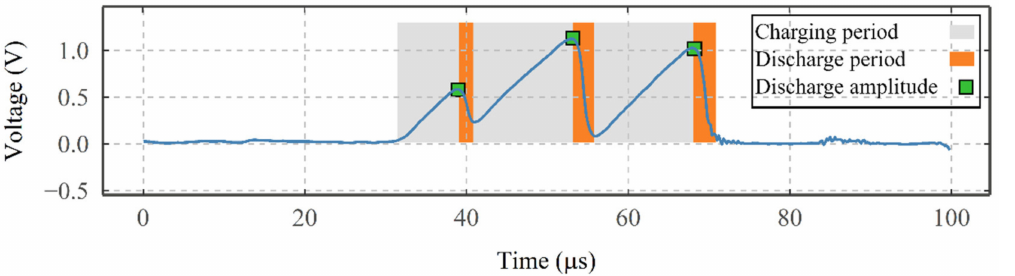
Figure 9. The charging and discharging periods, and the maximum discharge amplitude observed within the signals from VADC, in the speed test and captured at 2000